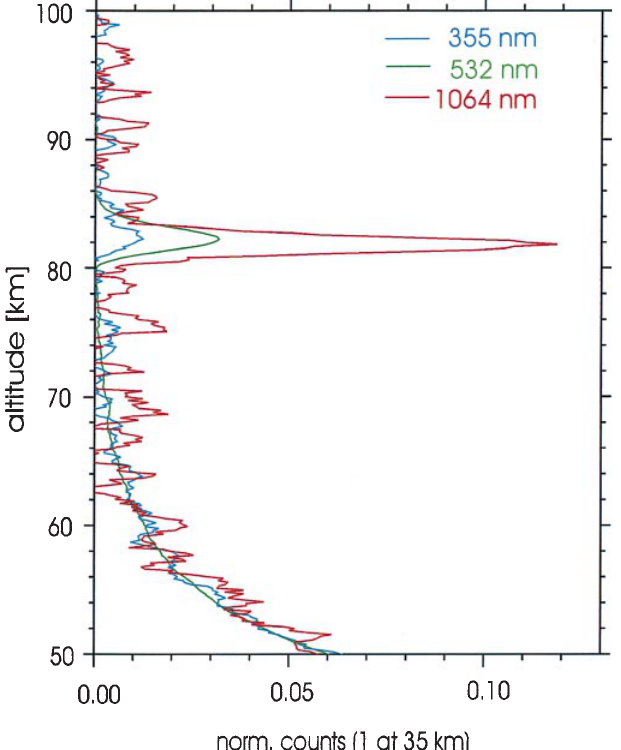
Fig. 9. A daylight, 3-colour NLC observation. The data were collected July 16, 1998, during a NLC event overhead the ALOMAR observatory. The signals were integrated for 2.8 h. During the integration time, the sun was continuously above the horizon and its elevation angle varied from 26 (cid:176) to 12 (cid:176) . Shown are the profiles of normalized counts (see text) for the three wavelengths 1064 , 532 , and 355 nm . The NLC layer is clearly seen in all three colours